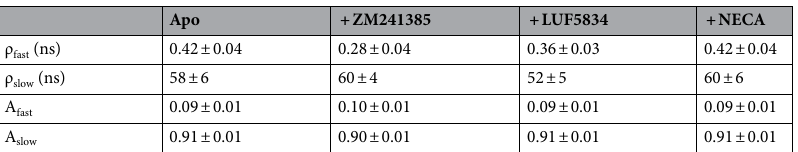
Table 2. Fluorescence anisotropy decay parameters of A 2A R(V229C 6.31 )-BODIPY-FL in different ligand states. The experimental data (Fig. 2) were fitted to multi-exponential decay model (Eq. 3b). Standard deviations were estimated by parametric bootstrapping.